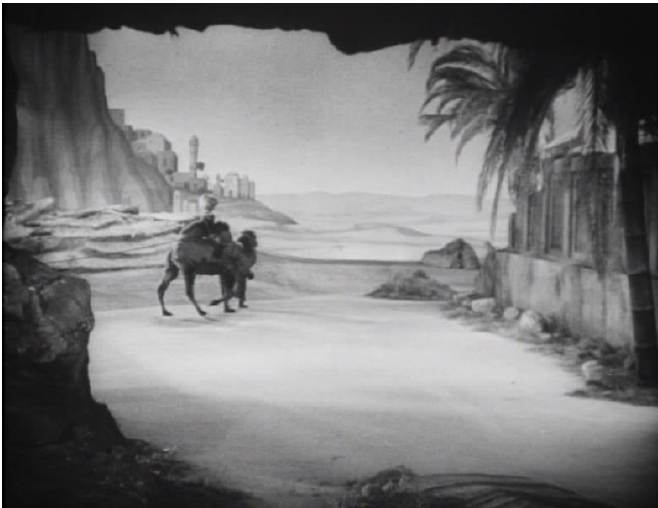
Figure 10. During Free and Easy ’s movie -in-the-movie, Elmer leads his camel, which in turn pulls his airplane, into the desert wilderness: a liminal tragicomedic space appropriate for the appearance of the sad